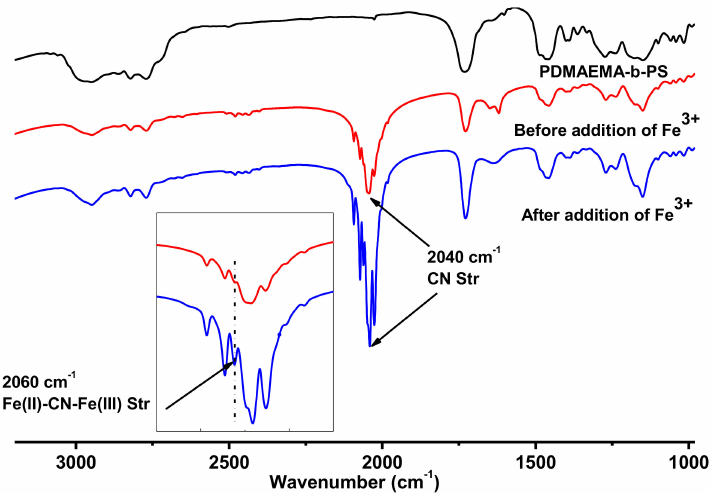
Figure 4. FT-IR spectra for PDMAEMA-b-PS, nanocapsules before addition of Fe 3+ and after addition of Fe 3+ . The inserted box shows the enlargement of the curves (1900 to 2100 nm wavelength) of capsules before and after addition of Fe 3+